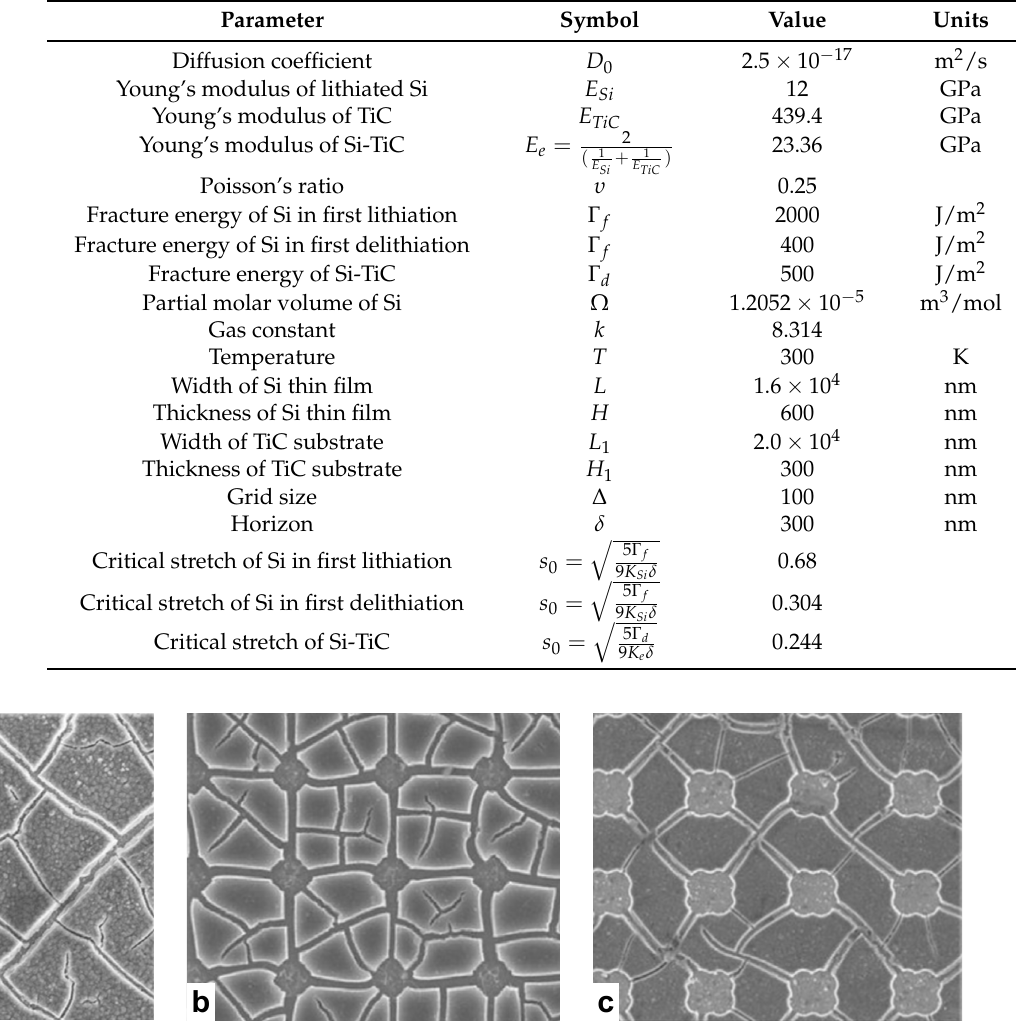
Figure 3. Fracture patterns in ( a ) continuous silicon thin film, ( b , c ) patterned films. Reproduced with permission